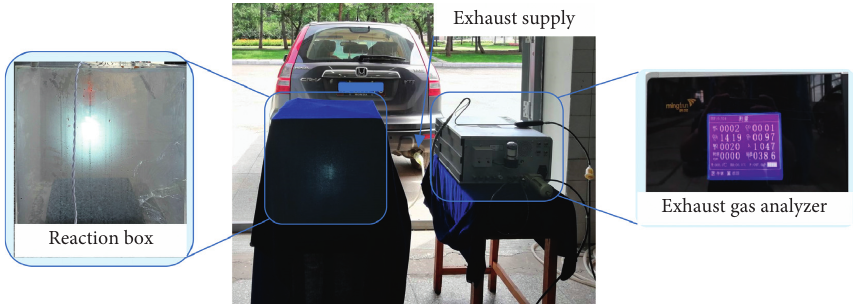
Figure 3: The photocatalytic degradation test.